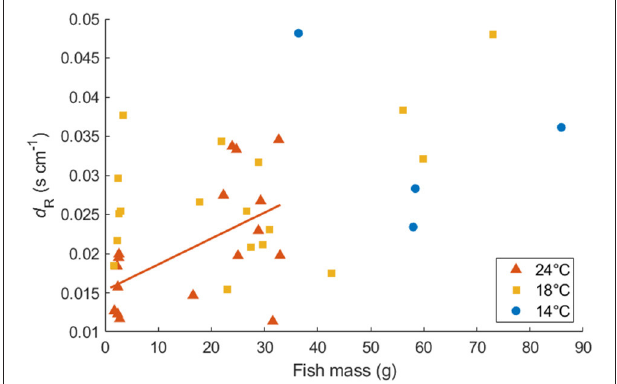
FIGURE 4 | Relationship between d R (s cm − 1 ) and body mass for Northwest stock Pacific chub mackerel at 24, 18, and 14 ◦ C. The solid red line represents the linear regression of d R at 24 ◦ C as a function of fish mass: d R = 0.00033 W + 0.015 ( r 2 = 0.303, p =